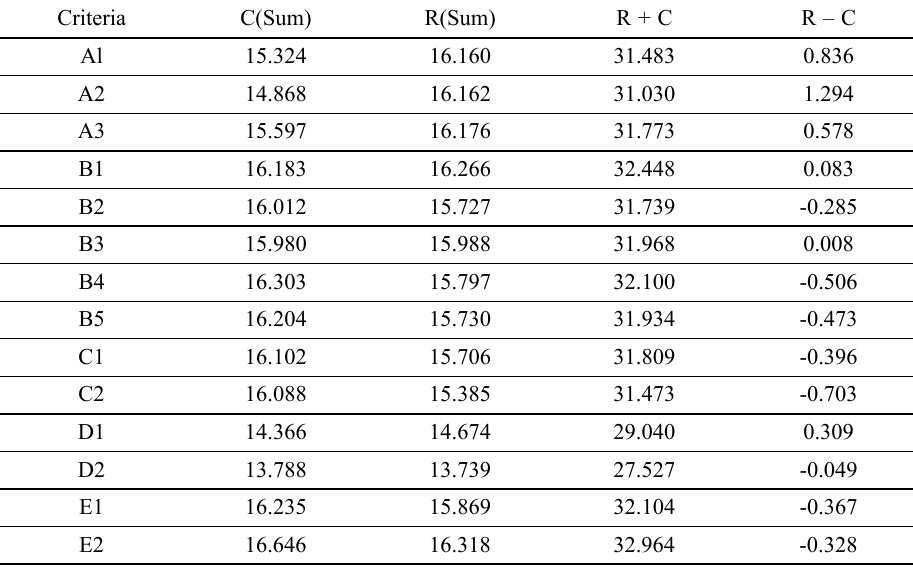
Table 4 su mmarizes the sum of influences given to and received from the criteria: Table 4. The sum of influences given and received among the criteria